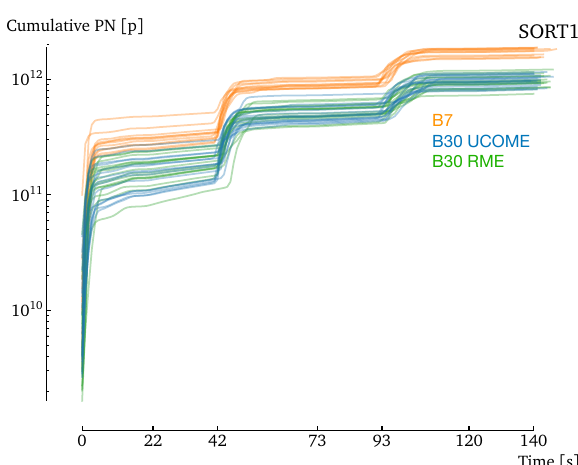
Figure 11. The cumulative PN emissions along the SORT 1 test runs indicate a progressive decrease in PN emissions for B30 RME and B30 UCOME compared to B7.